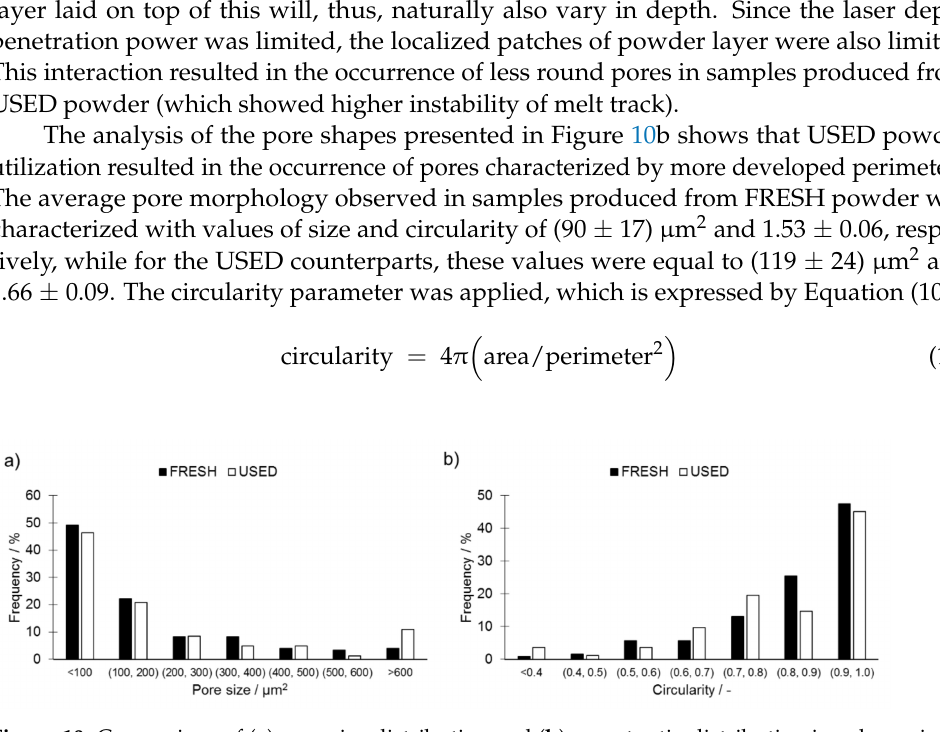
Figure 10. Comparison of ( a ) pore size distribution and ( b ) aspect ratio distribution in cubes printed from FRESH and USED Ti6Al4V powders, highlighting the appearance of less circular pores in samples 3D printed using USED Ti6Al4V